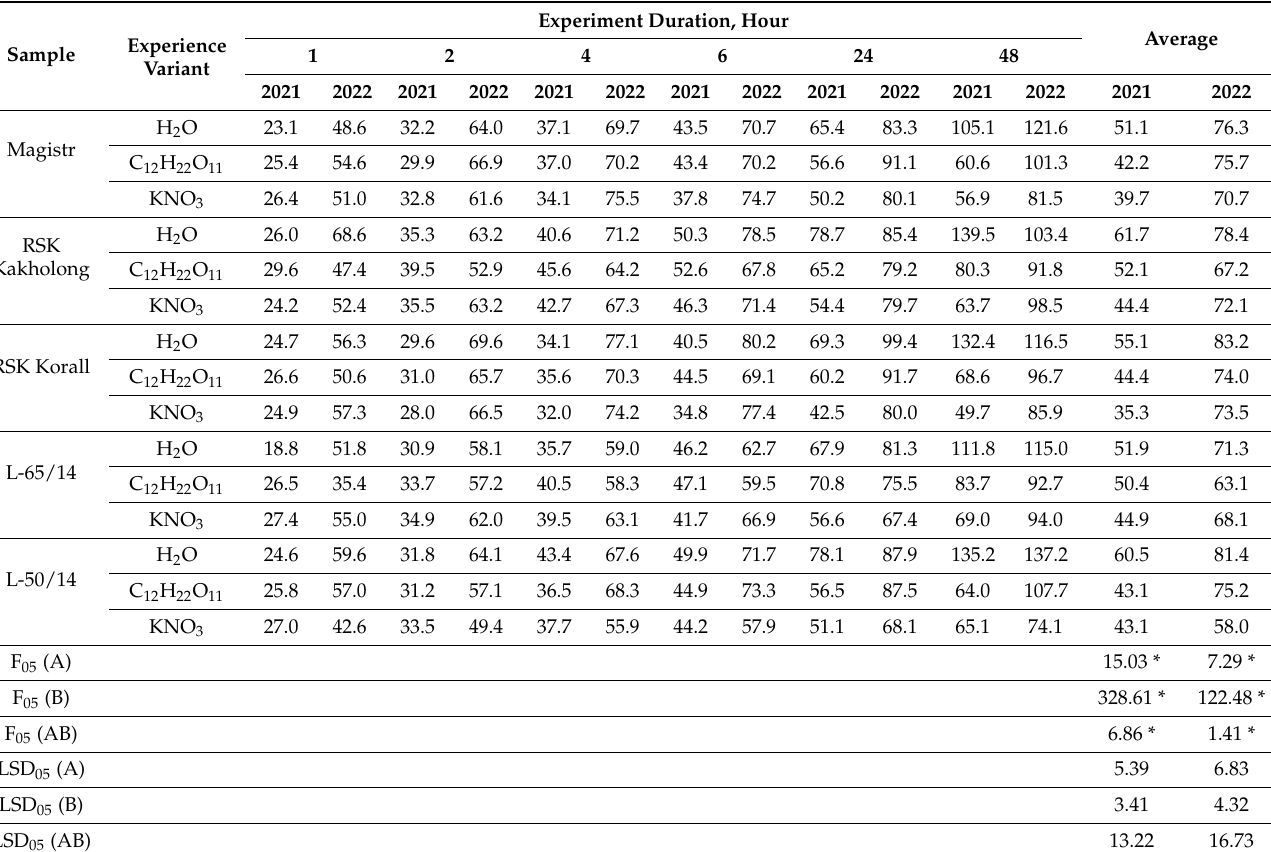
Table 3. Degree of swelling of grain sorghum seeds in osmotic solutions (2021–2022),